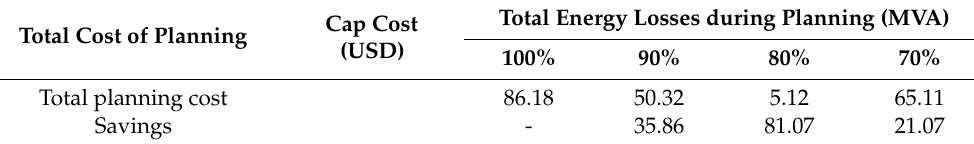
Table 15. Total costs of the planning in the four scenarios